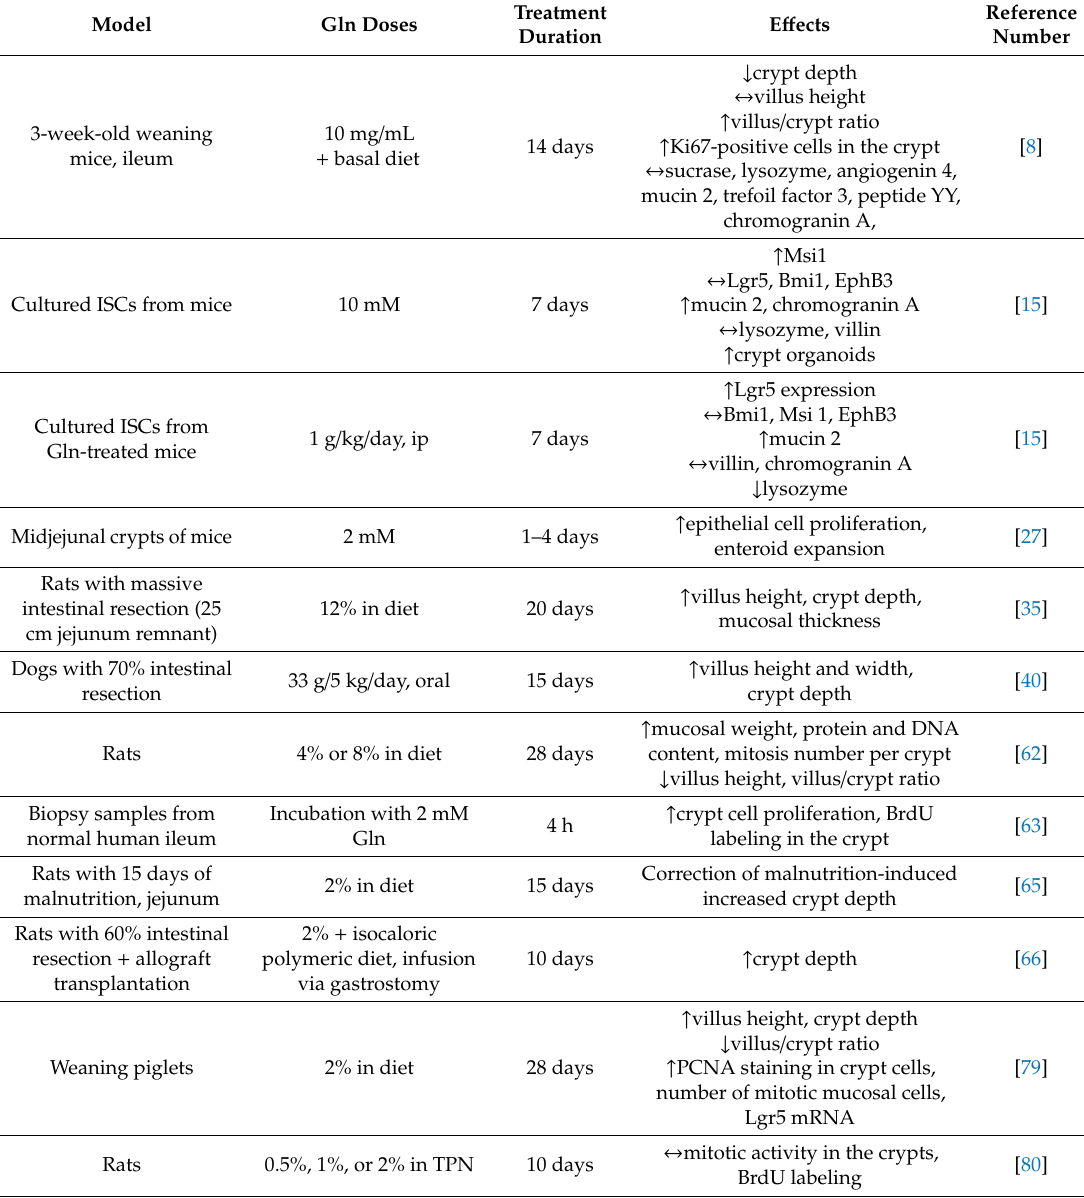
Table 2. E ff ects of glutamine treatment on intestinal crypt cells and stem